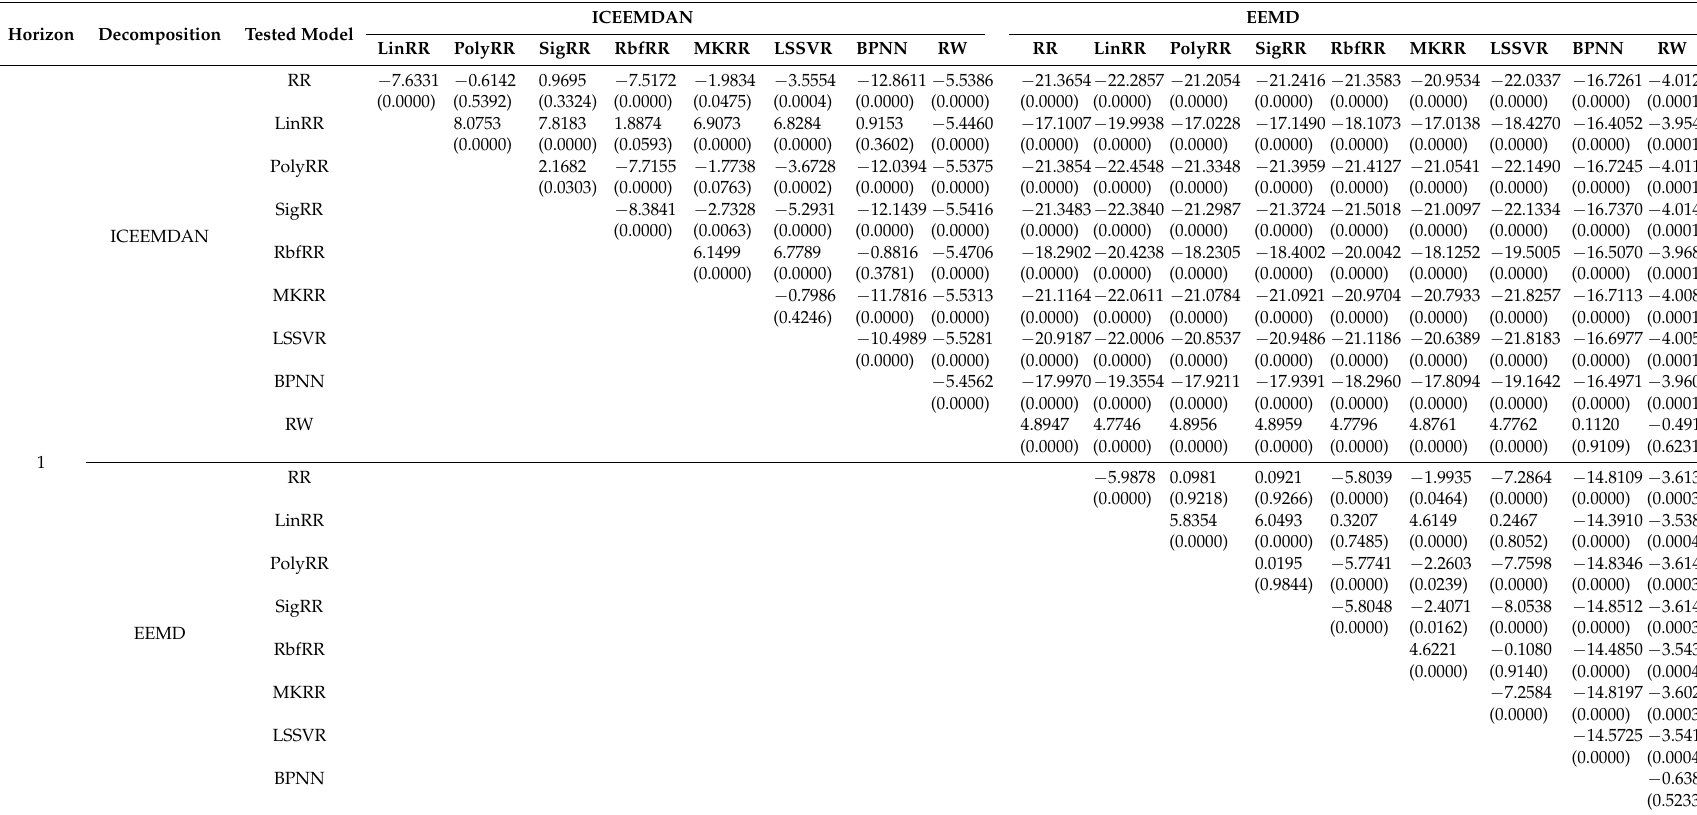
Table 5. The Diebold-Mariano (DM) test results of ensemble